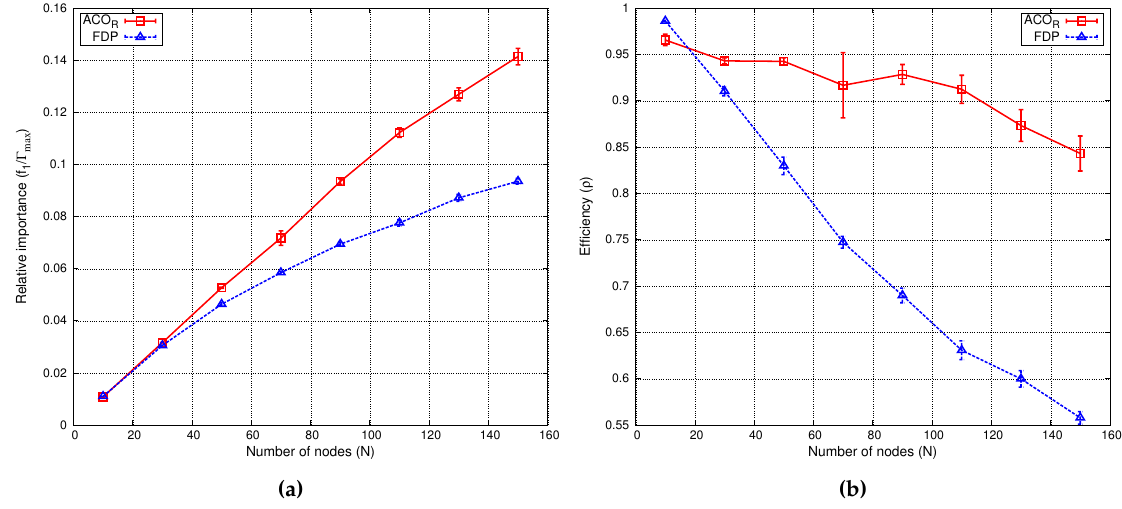
Figure 8. Performance comparison of ACO R -based versus the four-directional placement (FDP) heuristic.